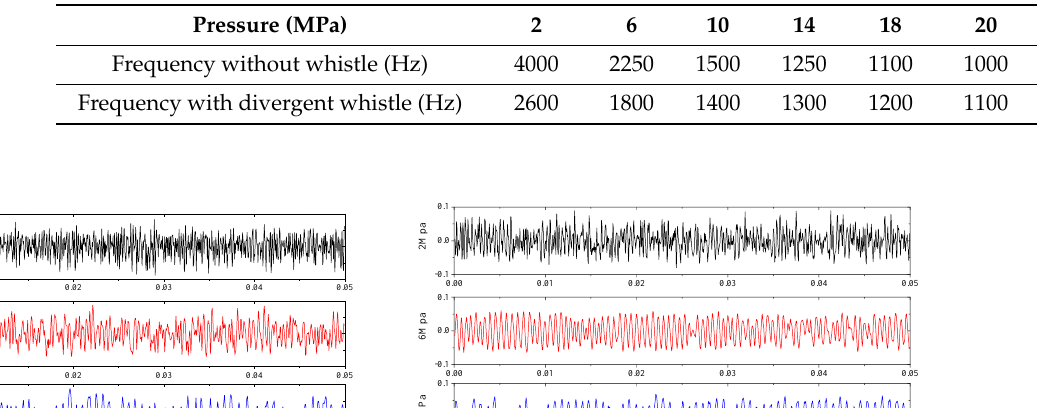
Table 2. The main frequency position at different pressures.